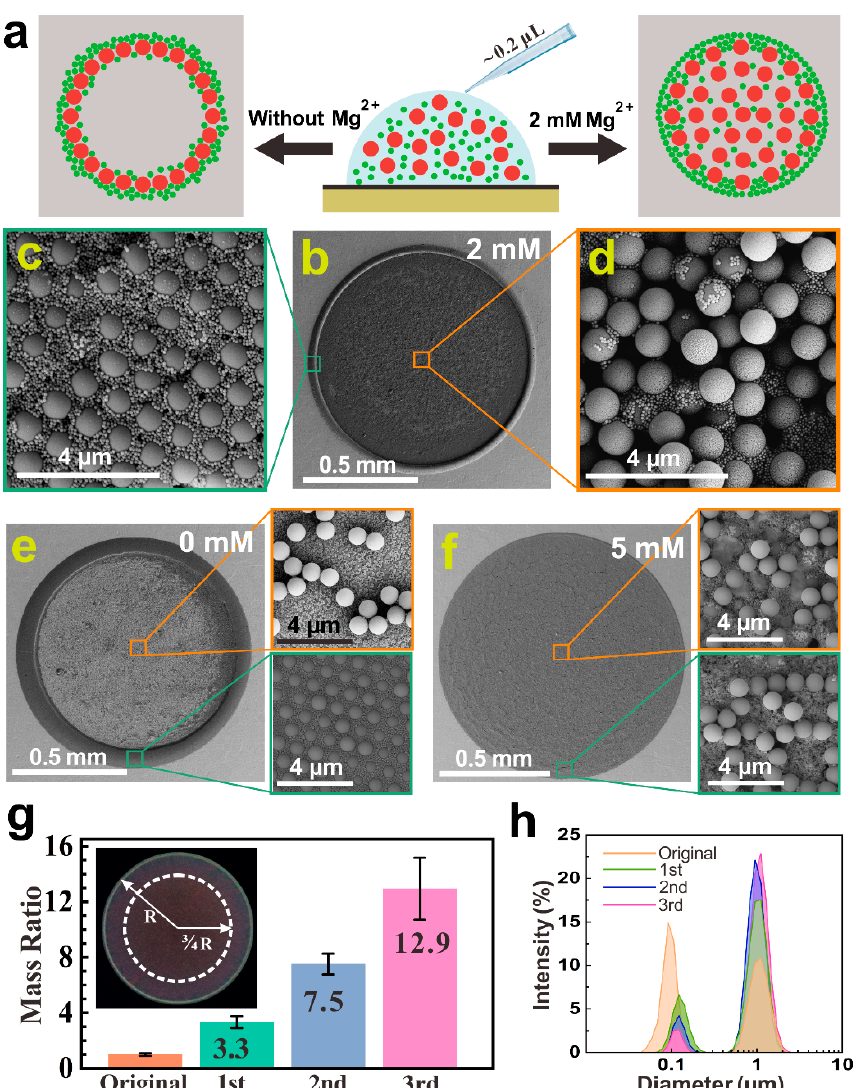
Figure 1. ( a ) Schematic diagram of the spontaneous separation between large particles (red spheres) and small particles (green spheres) in a droplet (light blue hemisphere) by adding trace amounts of cations. ( b – d ) SEM images of the deposit pattern dried from the suspension droplet containing bi- dispersed F-PS particles (1.0 μ m and 0.1 μ m in diameters) and 2.0 mM MgCl 2 on graphene. ( e , f ) SEM images of the deposit patterns dried from the suspension droplets containing bi-dispersed F-PS particles without salts ( e ) and with 5.0 mM MgCl 2 ( f ) on graphene. ( g ) The mass ratio between particles with diameters of 1.0 μ m and 0.1 μ m after multiple separating cycles in the presence of 2.0 mM MgCl 2 . The inset displays the selected sampling regions (i.e., the area surrounded by a white dashed circle) in the measurements. Error bars represent the standard deviation from at least three independent replicates. ( h ) Mass distribution with respect to particle diameters after multiple separating cycles. The intensity (%) represents the mass percentage of particles of different sizes.